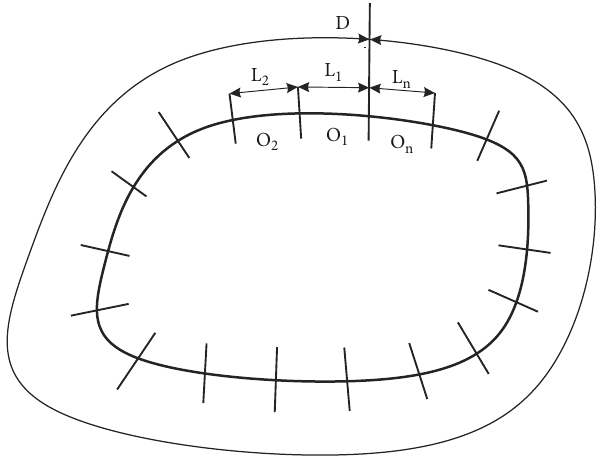
Figure 8: Concept of discretization of the